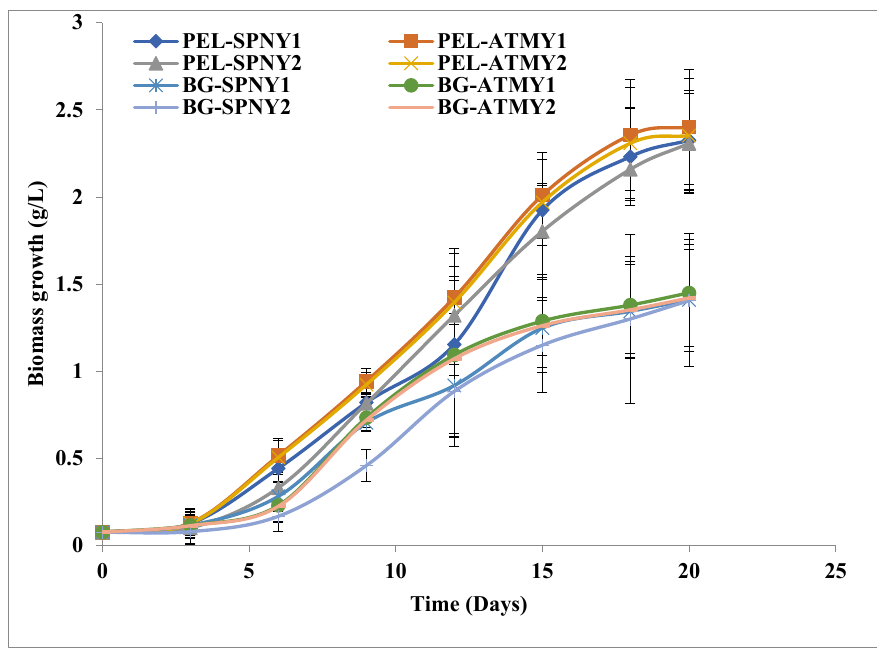
Figure 6. Growth of C. pyrenoidosa at solar inclination angles of 47.9°. Figure 7a–d illustrated the growth pattern biomolecules of C. pyrenoidosa at a solar inclination angle 47.9 ◦ , and Table 2 listed the highest biomolecule yields and productivities of PEL and BG-11. The biomolecule profile of C. pyrenoidosa was also analyzed at solar inclination angle 47.9 ◦ . Carbohydrate yield and productivity were analyzed at 0.54 g/L and 28.90 mg/L/D, respectively, with PEL in February–March (PEL-SPNY2) and 0.48 g/L and 25.22 mg/L/D, respectively, in BG-11 (BG-SPNY2) at solar inclination angle 47.9 ◦ (Table 2). The percentage of carbohydrates with BG-11 ranged from 33.37 to 34.40% and was more than ≈ 10% higher than PEL. Figure 7a shows the carbohydrate concentration of C. pyrenoidosa in both seasons in FPPBR. De Winter et al. [34] suggested that nitrogen limitation triggers carbohydrates biosynthesis in algal cells. Carbohydrates are considered an essential component for bioenergy production due to their easily fermentable ability into bioethanol and biobutanol [35]. Algae-derived carbohydrates have a significant role in pharmaceutical applications [36]. The accumulations of carbohydrates depend on the algal species and growth